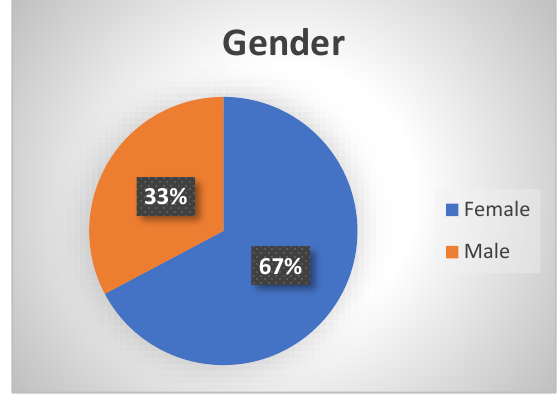
Figure 23. Gender percentages of the 58 school students.